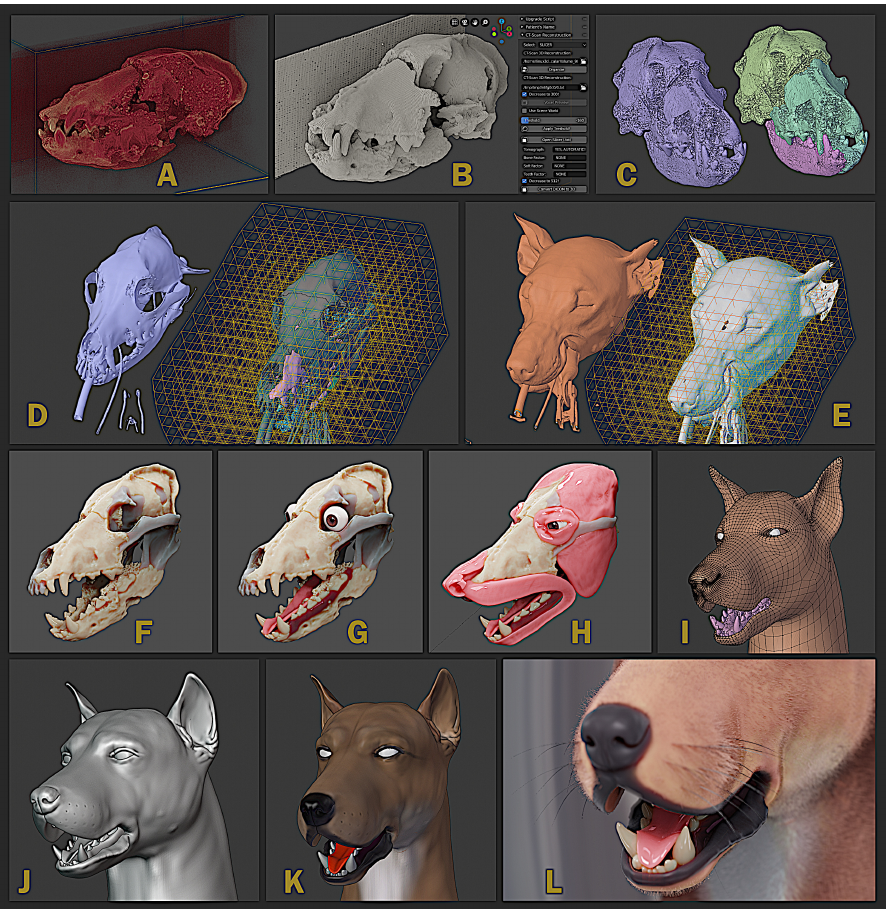
Figure 3. Snapshots of the process for the virtual tridimensional reconstruction of the Muge dog skull and, finally, the face (CC BY-SA 4.0). ( A ) Muge dog ´ s CT images in the voxel model. ( B ) Threshold of interest for the reconstruction (hounsfield 120-220). ( C ) Reconstructed mesh with bones in their expected anatomical position. ( D , E ) Bone and soft tissue deformation using the tomography of a virtual donor, and applying the lattice modifier. ( F ) Obtained model used as base for facial reconstruction. ( G ) Modelling of the teeth, tongue, eyes and other soft tissue structures. ( H ) Modelling of muscles in the correct position. ( I ) Low resolution modeling involved the bones and muscles, using the deformed mesh. ( J ) Digital sculpture obtained from smaller 3D mesh faces. ( K ) Digital pigmentation. ( L ) Final result, including the hair distributed along the body